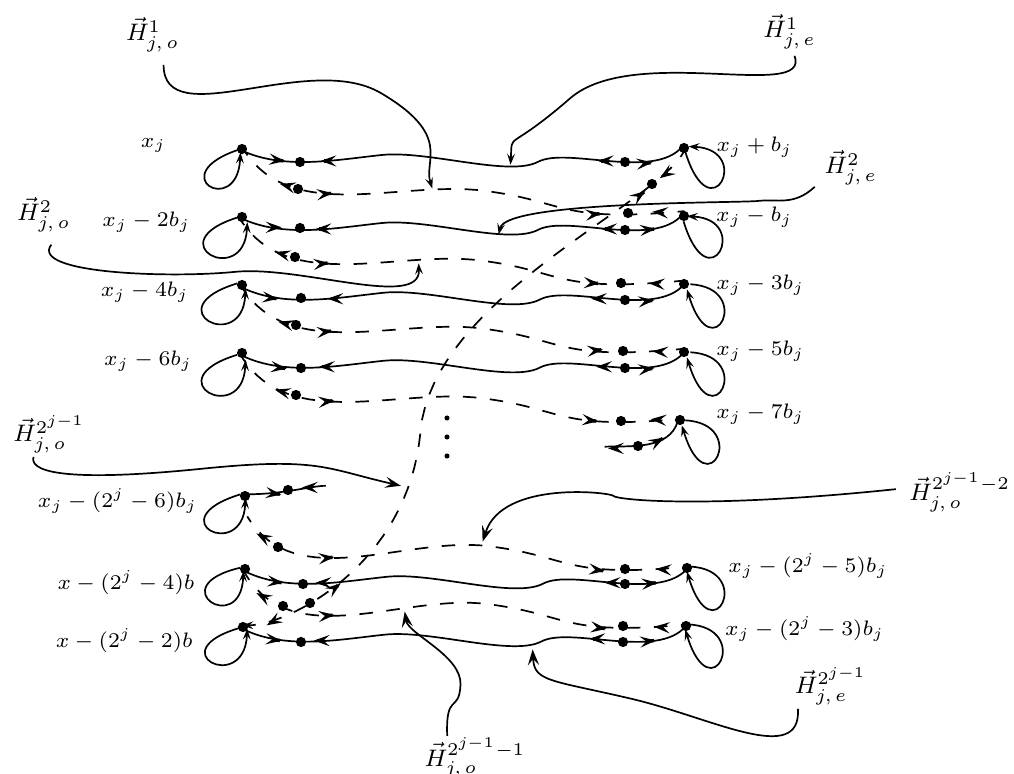
Fig. 7: 2 -diregular spanning bieulerian digraph ~H j constructed from ~H j,e and ~H j,o and loops added at each of the vertices of A j